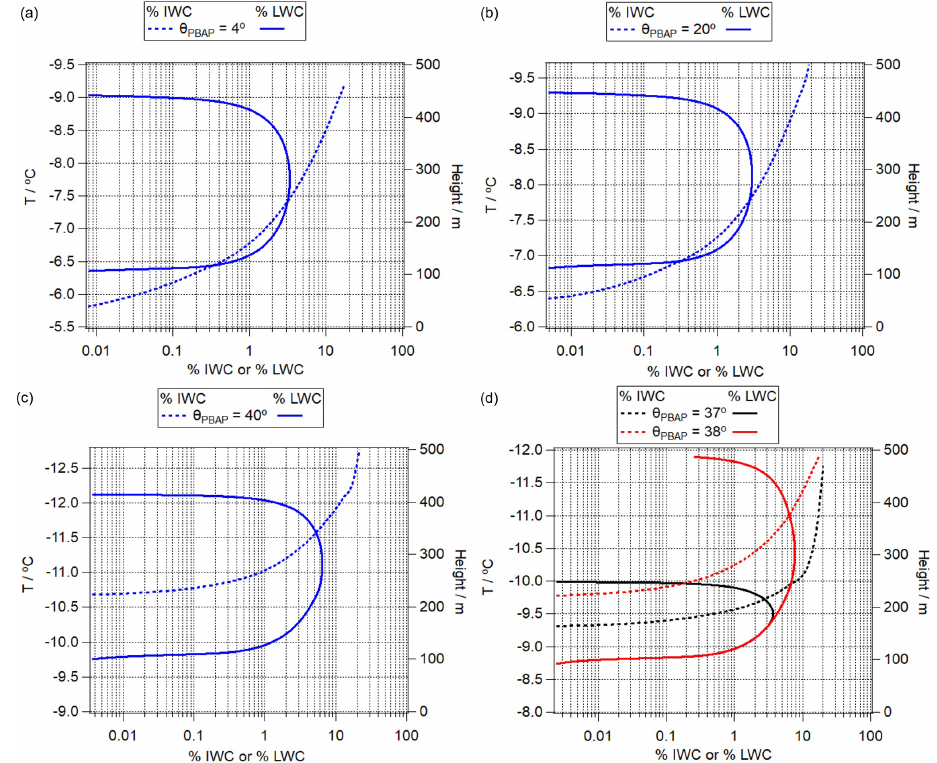
Figure 10. Percentage contribution of ice water content (%IWC, dashed lines) and liquid water content (%LWC, solid lines) to total adiabatic water content for θ PBAP of (a) 4 ◦ , (b) 20 ◦ , (c) 40 ◦ , and (d) 37 and 38 ◦ . The curves in the first three panels exhibit similar shapes for different temperature ranges; i.e., the Bergeron–Findeisen process starts at different temperatures. The last panel shows that even when the contact angle increases by 1 ◦ , the temperature, at which the %LWC fraction starts decreasing, differs